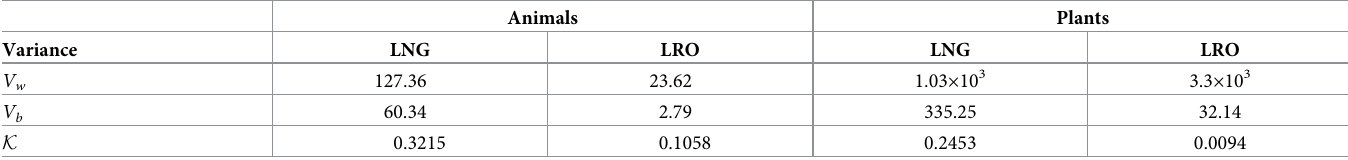
Table 4. Variance decomposition analysis of animals and plants. Results show the variance within population ( V coefficient ( K ) for longevity (LNG) and lifetime reproductive output (LRO).